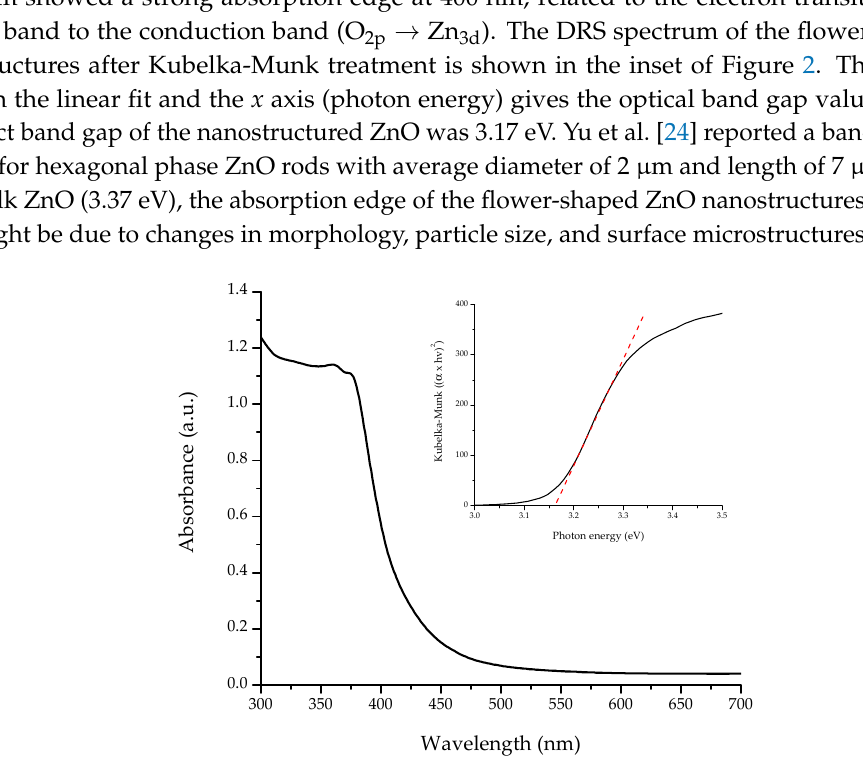
Figure 2. UV–vis diffuse reflectance spectrum of synthesized flower-shaped ZnO nanostructures. The inset shows their corresponding Kubelka-Munk transformed reflectance spectrum.